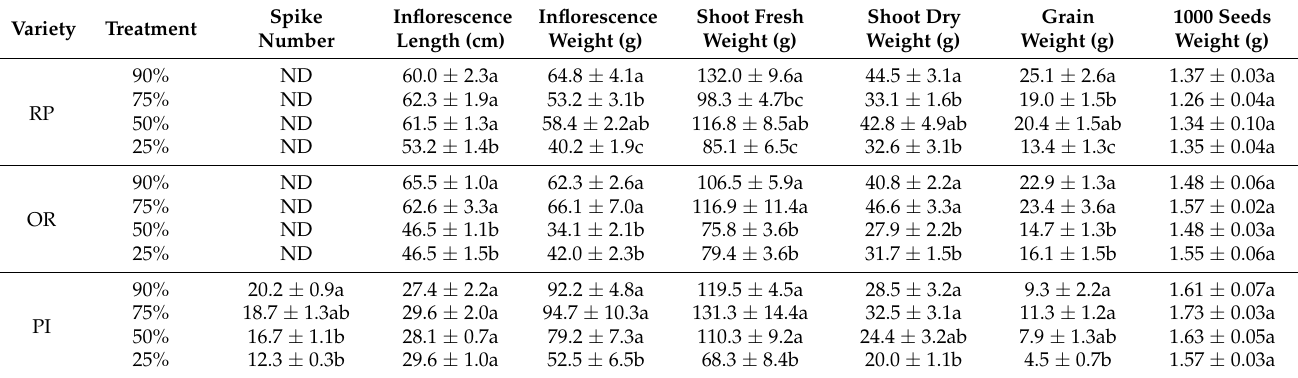
Values are means ( ± SE) of four replicates, for each treatment; different letters represent significant differences among the same variety according to LSD at p < 0.05 ( n = 4). ND = No